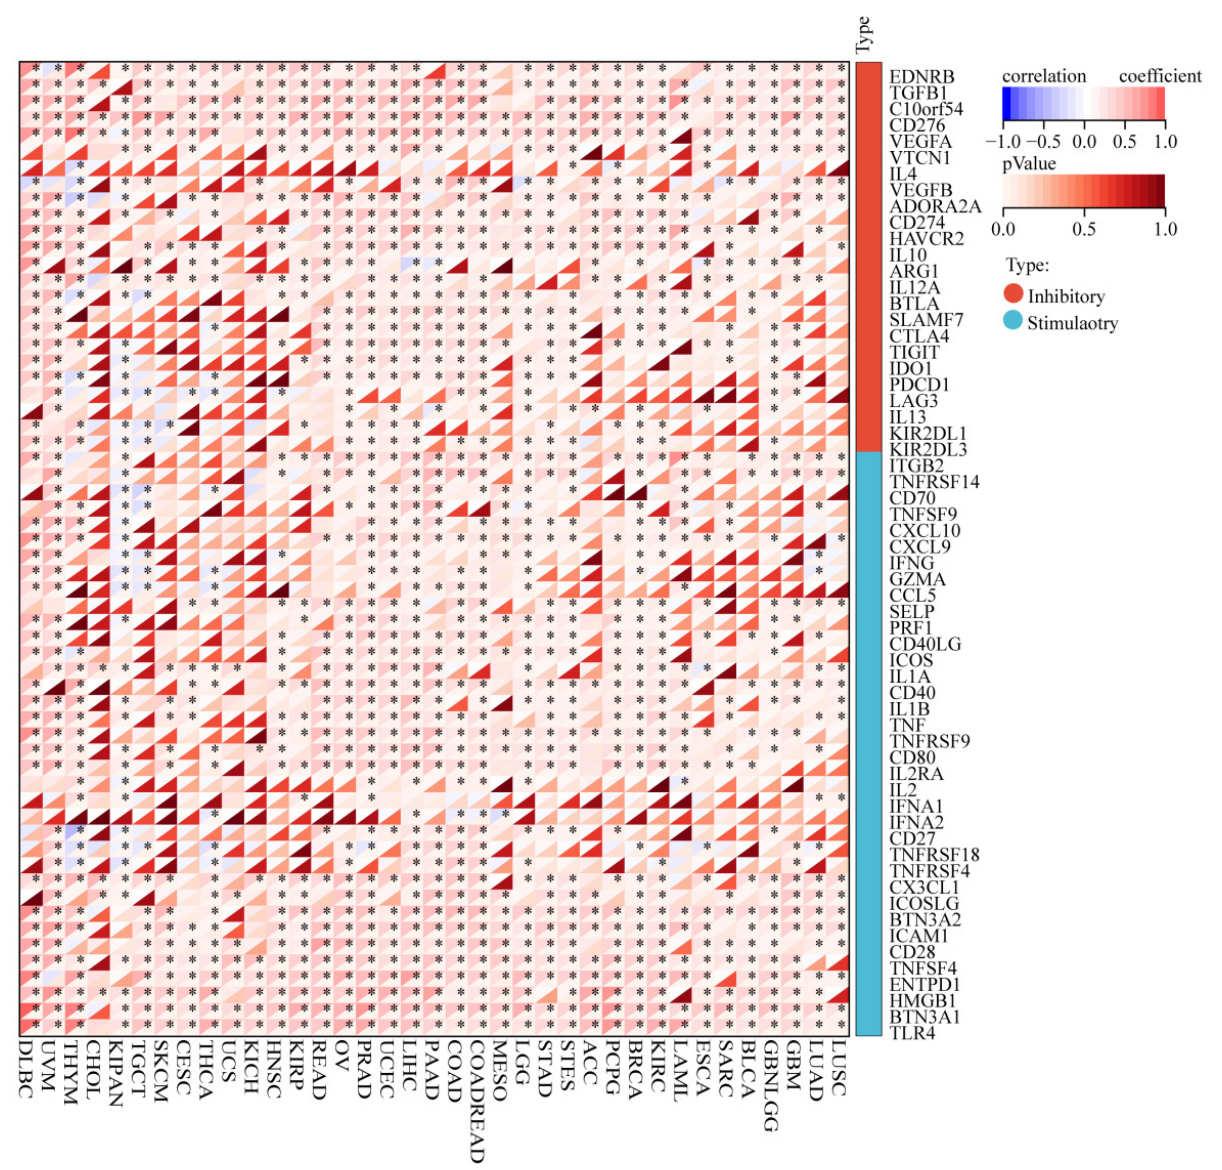
Figure 7. Correlation between ZDHHC7 expression and 60 immune checkpoint gene expressions across cancer types. * indicates p < 0.05.